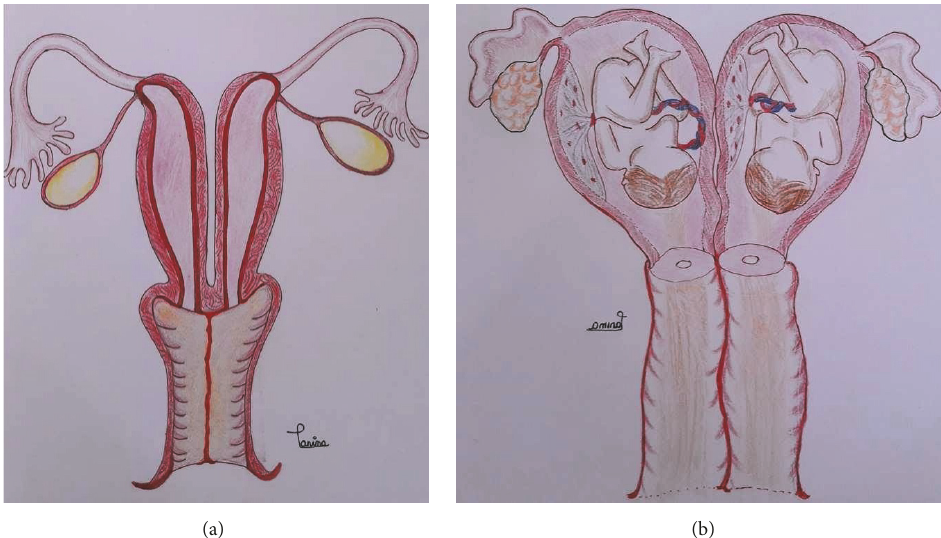
Figure 2: (a) Schematic diagram of nongravid didelphys uterus and (b) schematic diagram of gravid didelphys uterus with dicavitary twin.